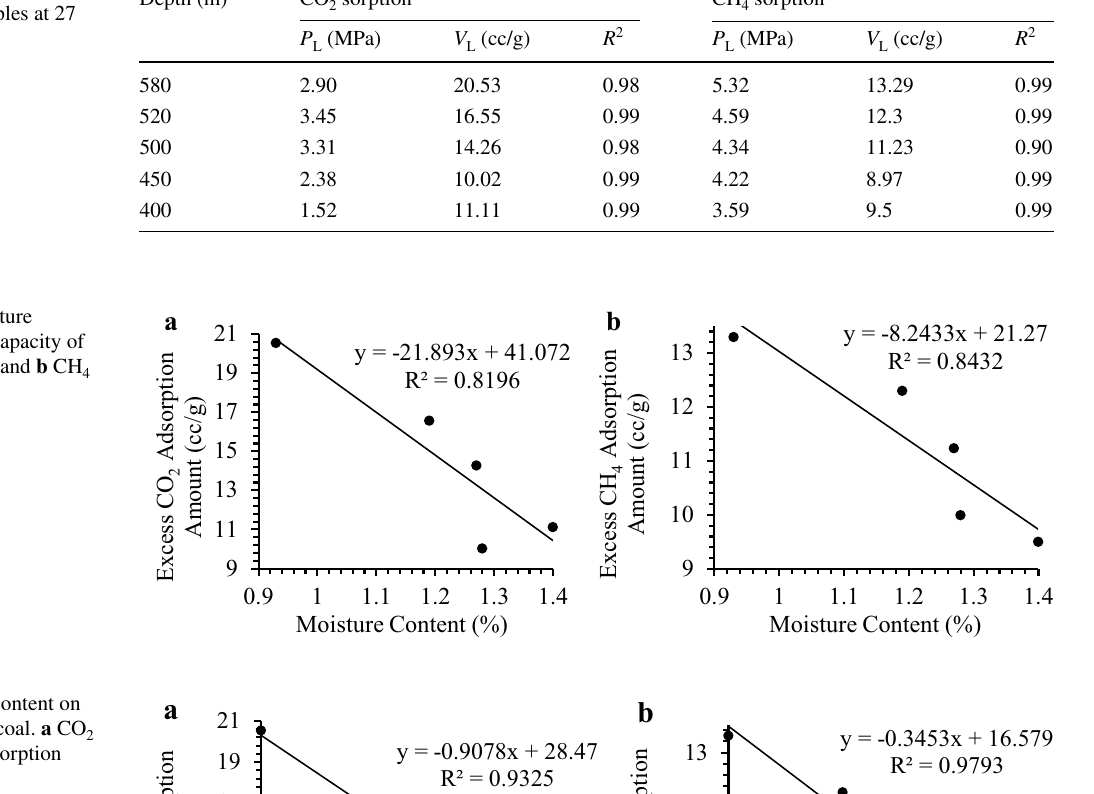
Fig. 9 Effect of ash content on sorption capacity of coal. a CO 2 sorption and b CH 4 sorption y = -0.9078x +